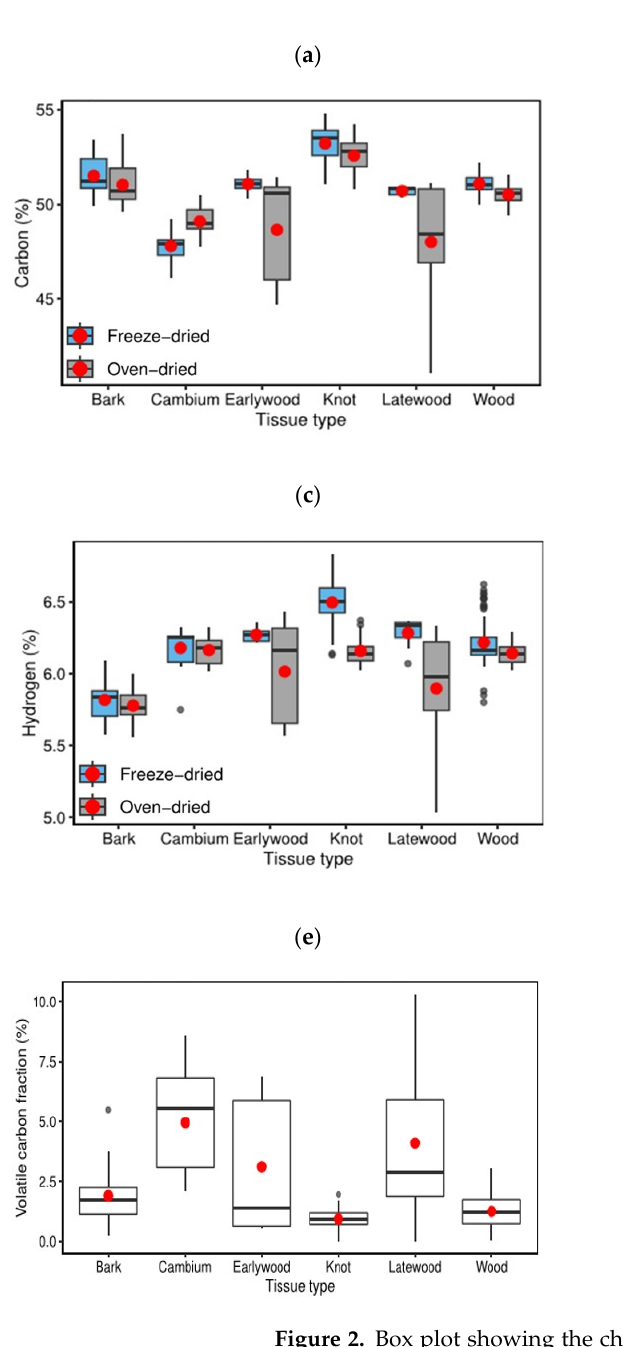
other hand, the content of ODN in the cambium was highest, followed by the bark and further in order of decreasing trend by earlywood, latewood, wood, and knot.